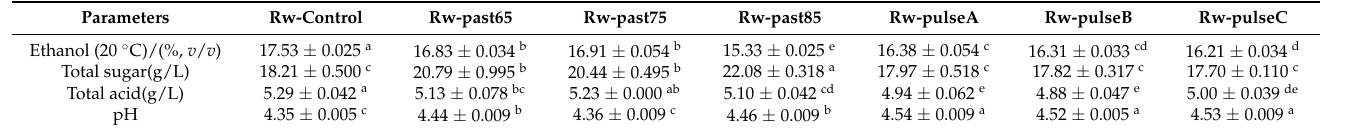
Table 2. Changes in physicochemical properties of SRW before and after